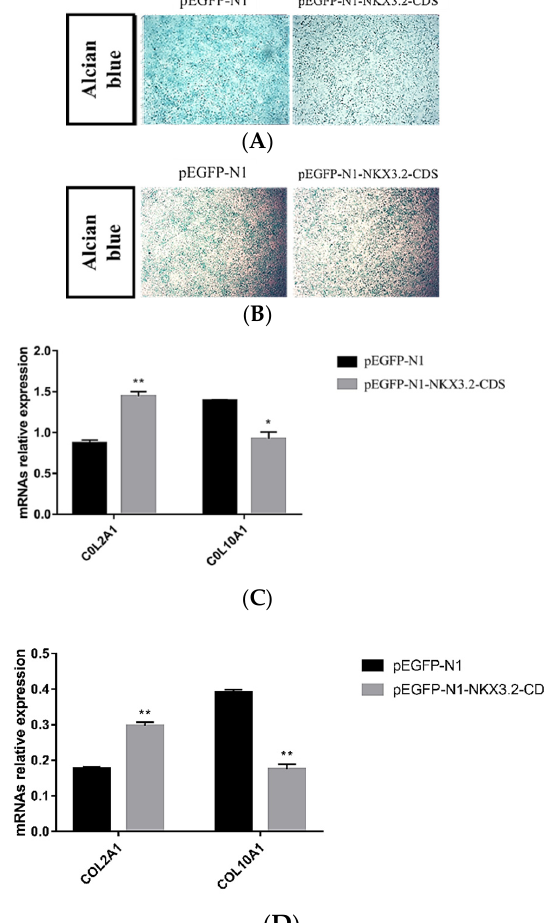
Figure 6. NKX3.2 inhibits chondrocyte differentiation. ATDC5 cells ( A , C ) and pig primary chondro- cytes ( B , D ) were cultured in chondrogenic differentiation media and treated with control pEGFP-N1 or pEGFP-N1- NKX3.2 -CDS. After 4 days, the cultures were stained with Alcian blue or harvested for mRNA isolation and qPCR analyses of COL2A1 and COL10A1 expressions. Scale bar: 200 um. * p < 0.05, ** p < 0.01, Student’s t -test.